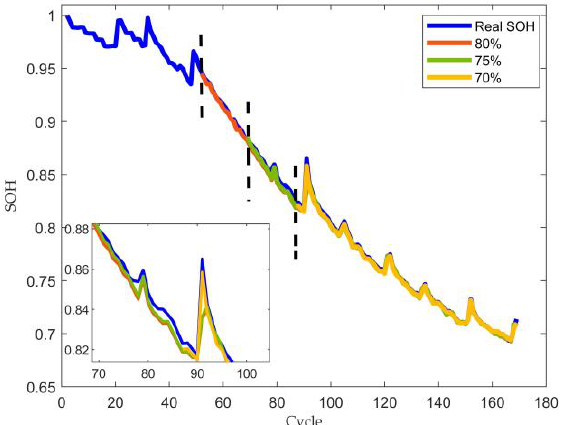
Figure 12. Different EOLs of SOH prediction results for B0005. Table 6. Prediction results of SOH based on the M4 model for the B0005 battery with different